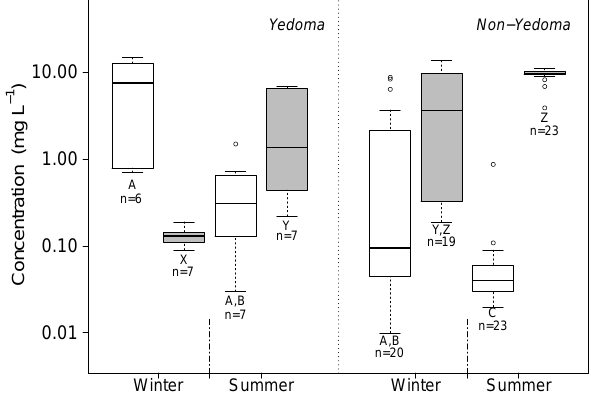
Figure 4. Examples of CH 4 oxidation patterns observed during the MO assays: (a) assay with no lag-phase, (b) assay with a 3-day lag-phase, and (c) assay with no detected activity. Straight lines are linear